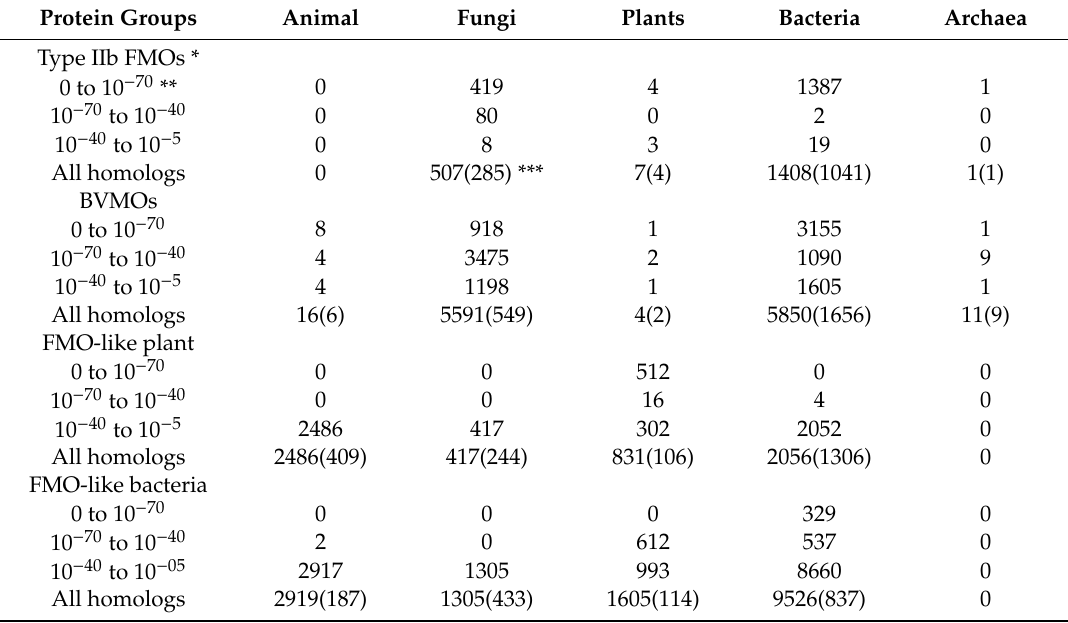
Table 1. Abundance of the homologs of the three groups of proteins in the main taxa, depending on the degree of their similarity (NCBI